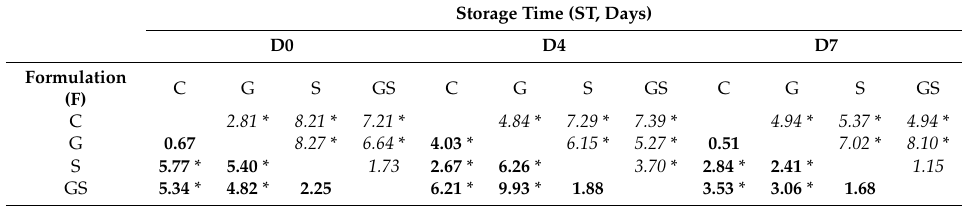
Table 4. Colour di ff erences ( ∆ E) within Storage Time (ST) between Formulation (F). Storage Time (ST, Days) D0 D4